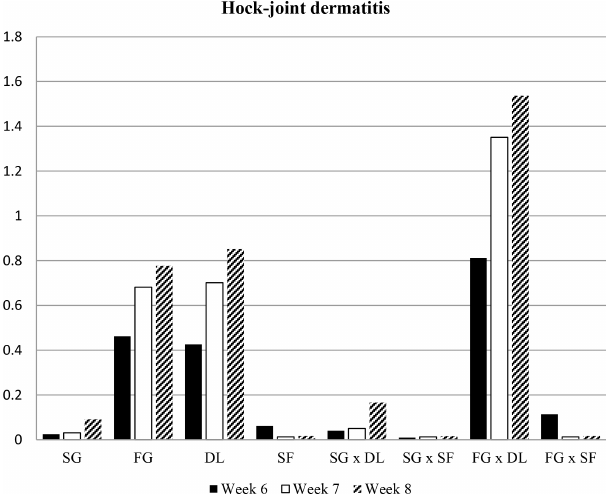
Figure 2. Mean values of hock-joint dermatitis scores of all